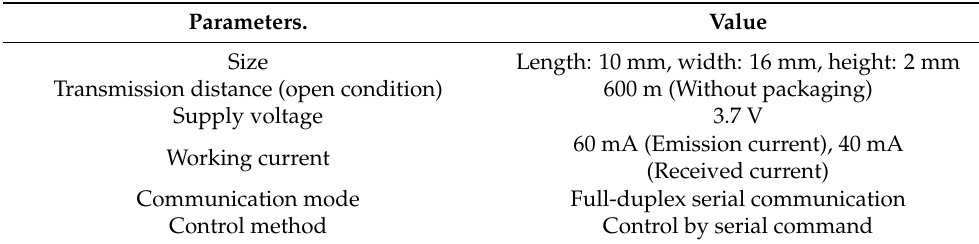
Table 2. Technical parameters of the wireless transmission module. Parameters.